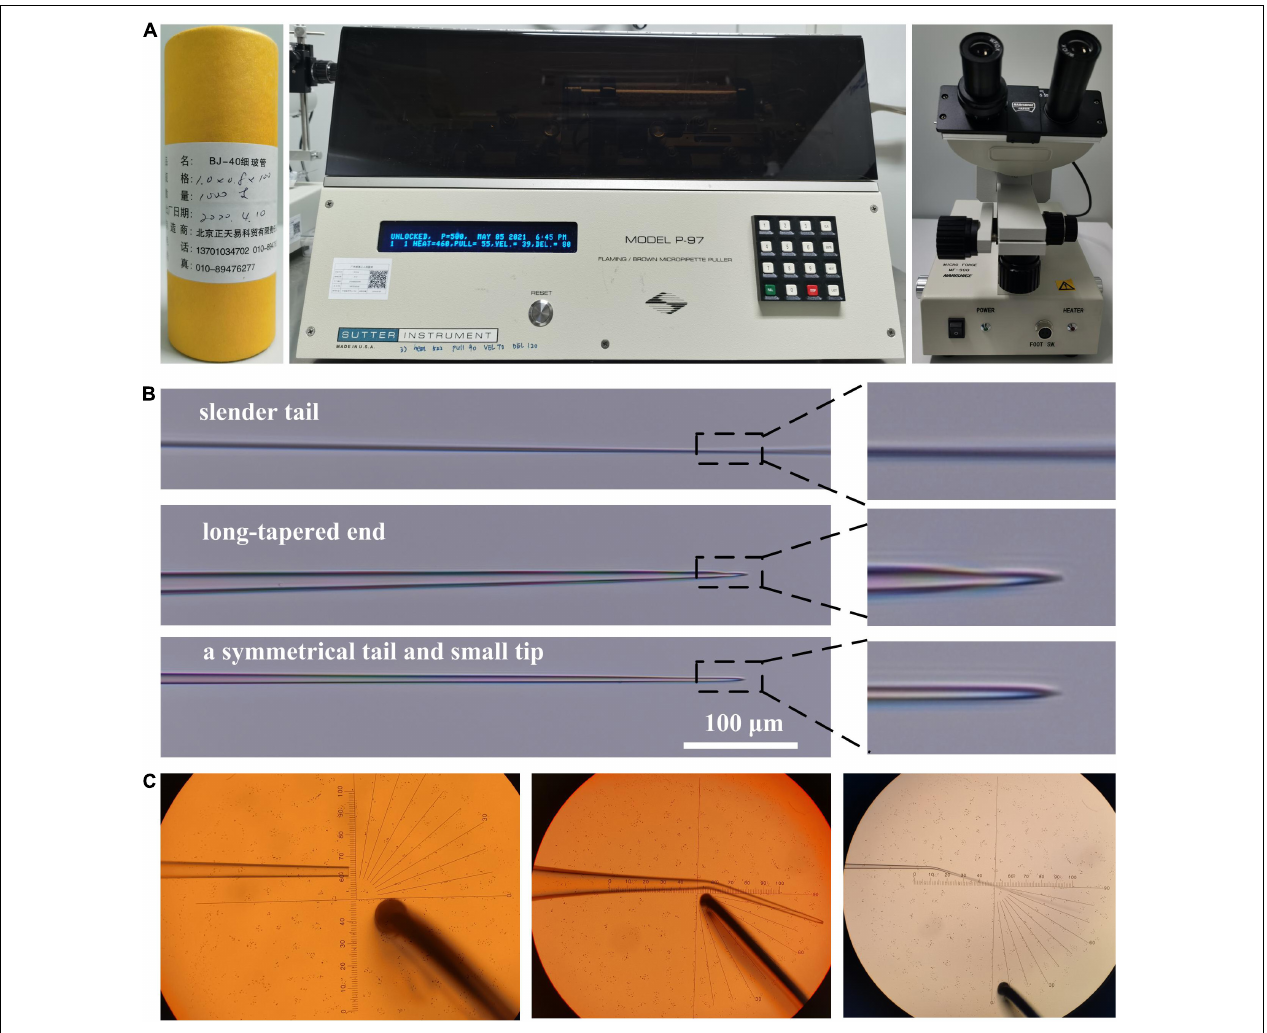
FIGURE 1 | Making holding and microinjection pipettes. (A) The capillary glass tube, the micropipette puller, and the microforging were used to make the holding and microinjection needles in this study. (B) Three types of the needle are produced from the micropipette puller. The needles with a symmetrical tail and small tip are ideal to make microinject pipettes. (C) The cutting diameter should be about 50 µ m, which is good for making a holding pipette (the objective lens is × 10). At a position about 2.5 mm away from the end of the pipette, the holding and microinjection needle will be bent for 15–20 ◦ (the objective lens is ×